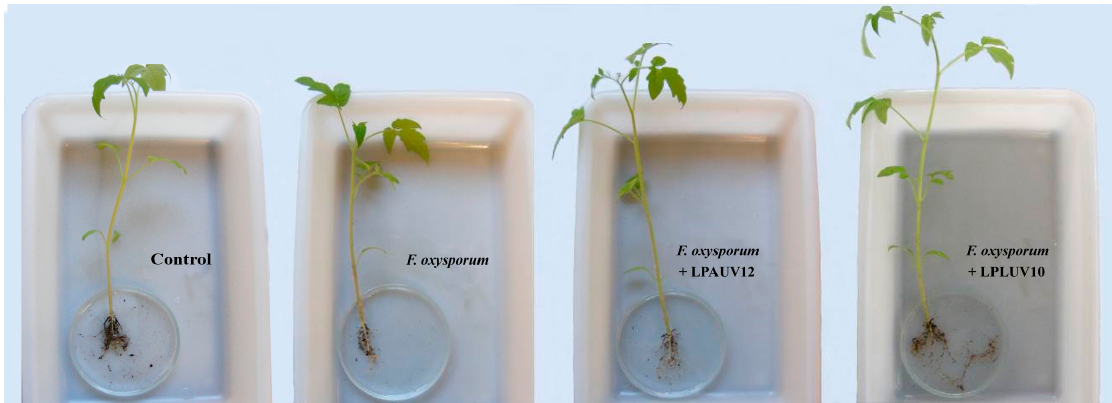
Figure 2. Qualitative effect of F. oxysporum on untreated L. esculentum plants and the bioprotective capacity of the studied lactic acid bacteria.